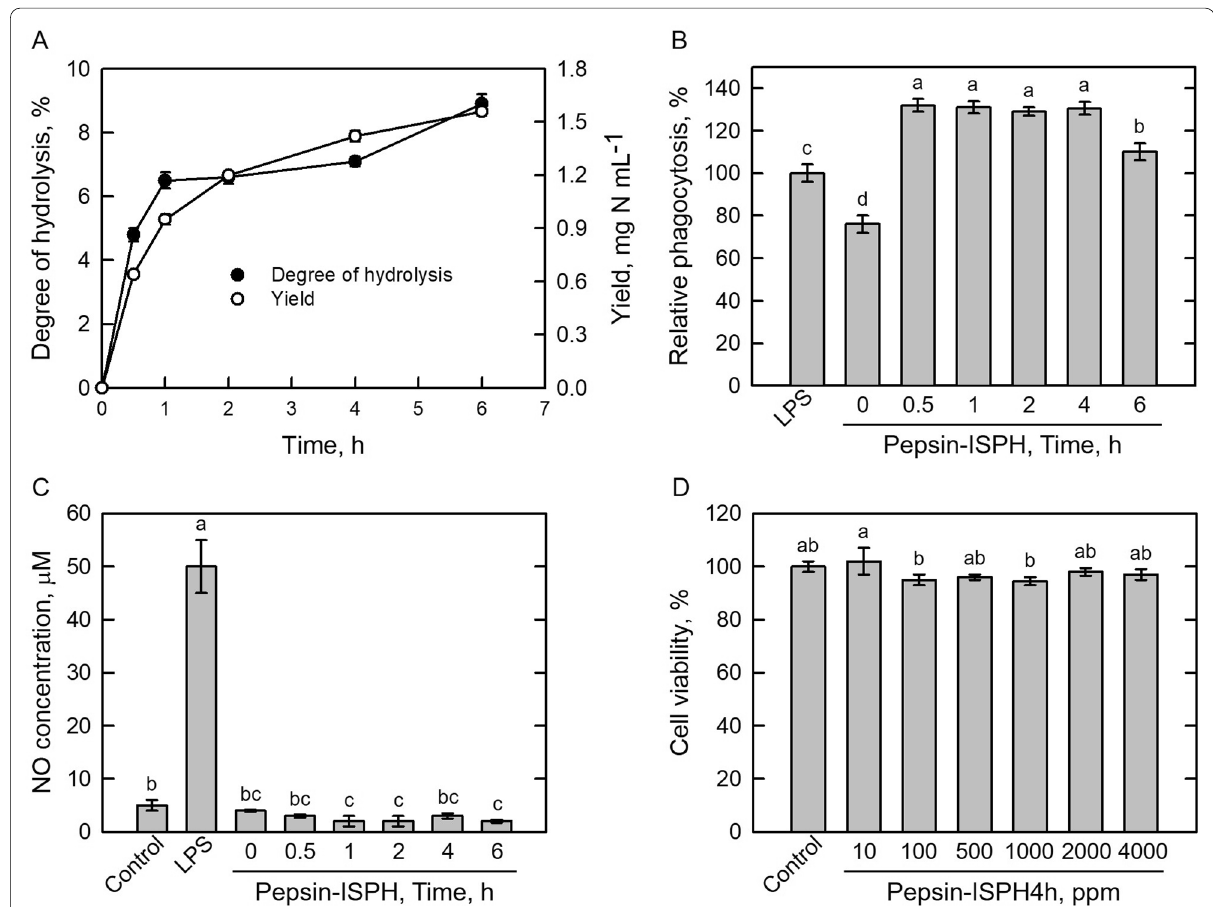
Fig. 1 Preparation of pepsin‑isolated soy protein hydrolysate (Pepsin‑ISPH). A effect of different hydrolysis time of isolated soy protein hydrolysate by pepsin on degree of hydrolysis ( ● ) and yield ( ○ ) in terms of TCA soluble nitrogen. B effect of 4000 ppm Pepsin‑ISPH with different hydrolysis time on relative phagocytosis (%) in mouse RAW246.7 macrophages. C effect of 4000 ppm Pepsin‑ISPH with different hydrolysis time on relative phagocytosis (%) in mouse RAW246.7 macrophages. D dosage effect of Pepsin‑ISPH4h on cell viability (%) in mouse RAW246.7 macrophages. LPS (1 ppm) was used as positive control. Bars represent mean standard deviation (SD; n 3). Mean with different letters are significantly different ± = ( p < 0.05) by Duncan’s multiple range